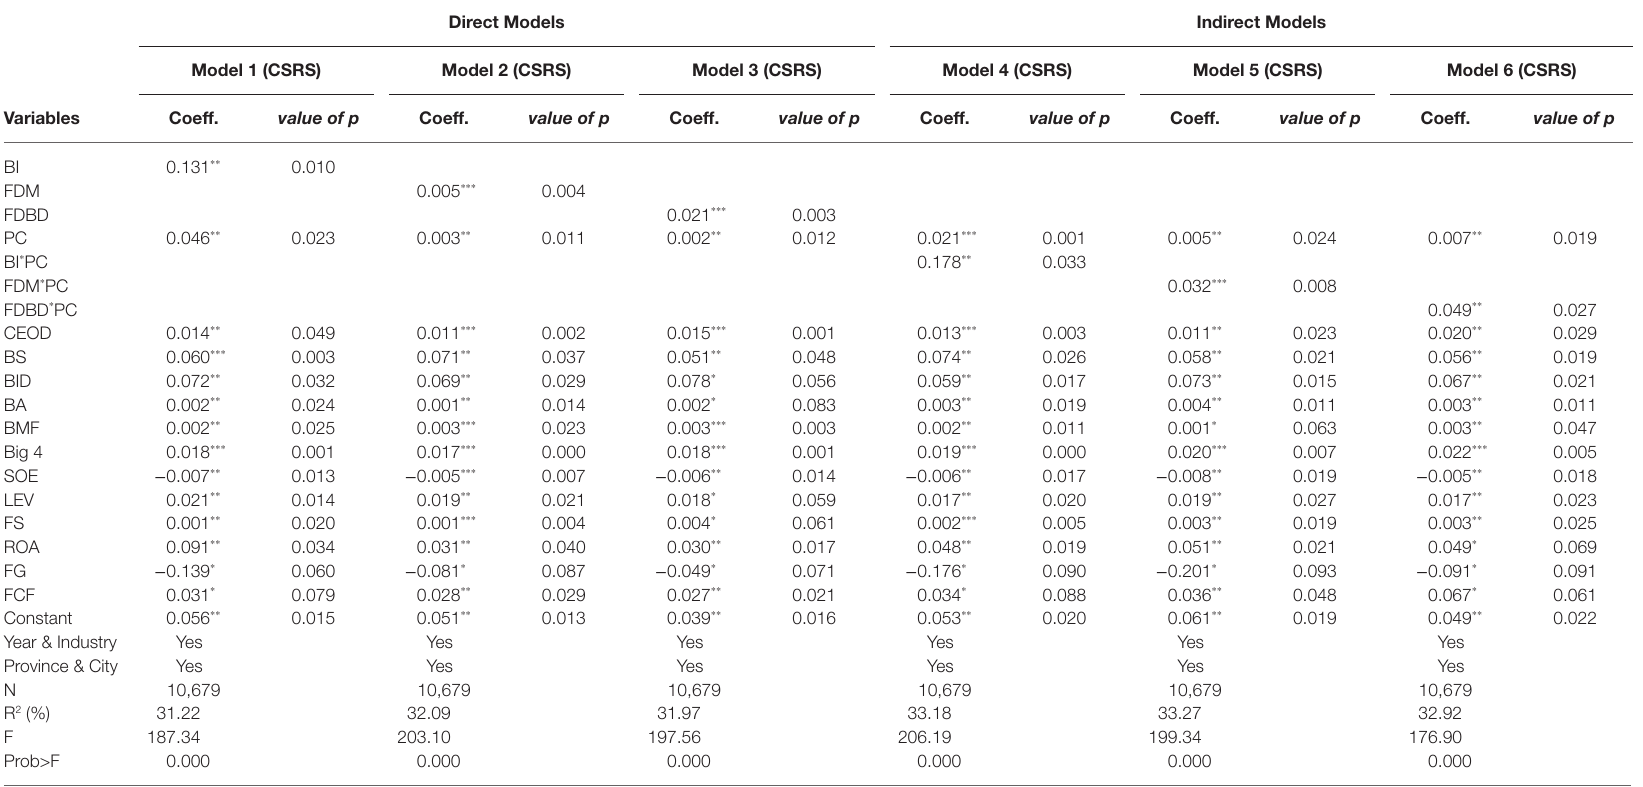
TABLE 6 | Alternative measures of